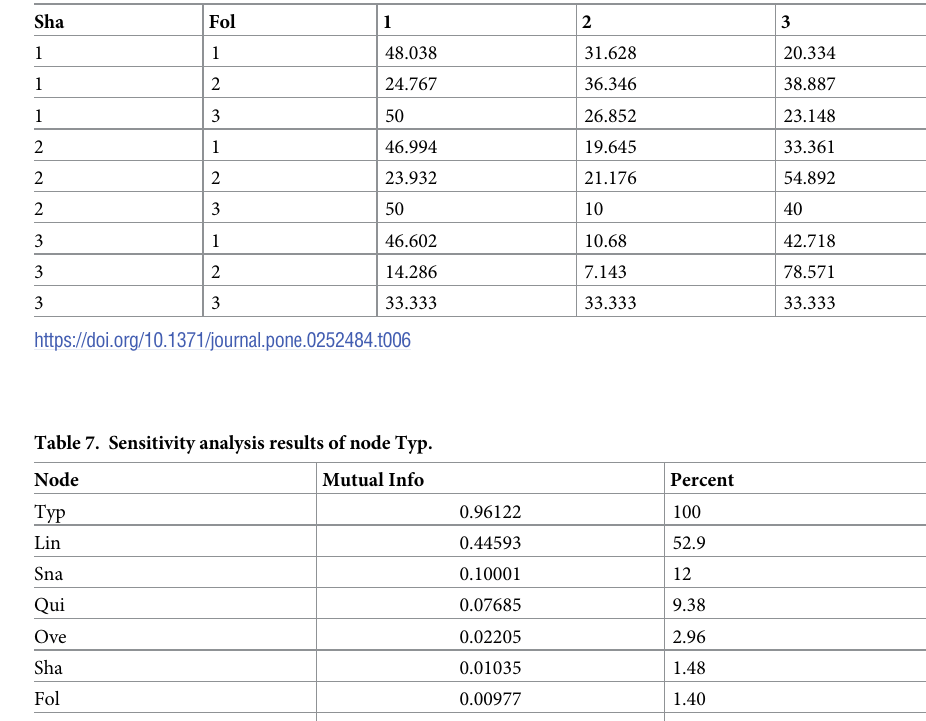
Table 6. CPT of node Sty.